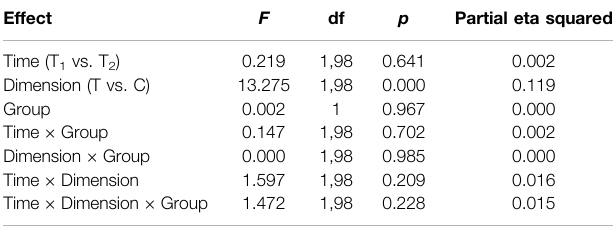
TABLE 4 | Predicting implicit measures. Effect